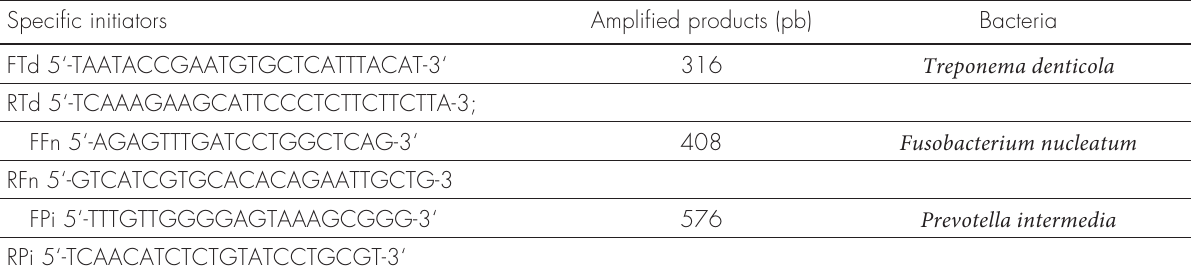
Table I. Primers and qPCR conditions to measure bacterial load. Specific initiators